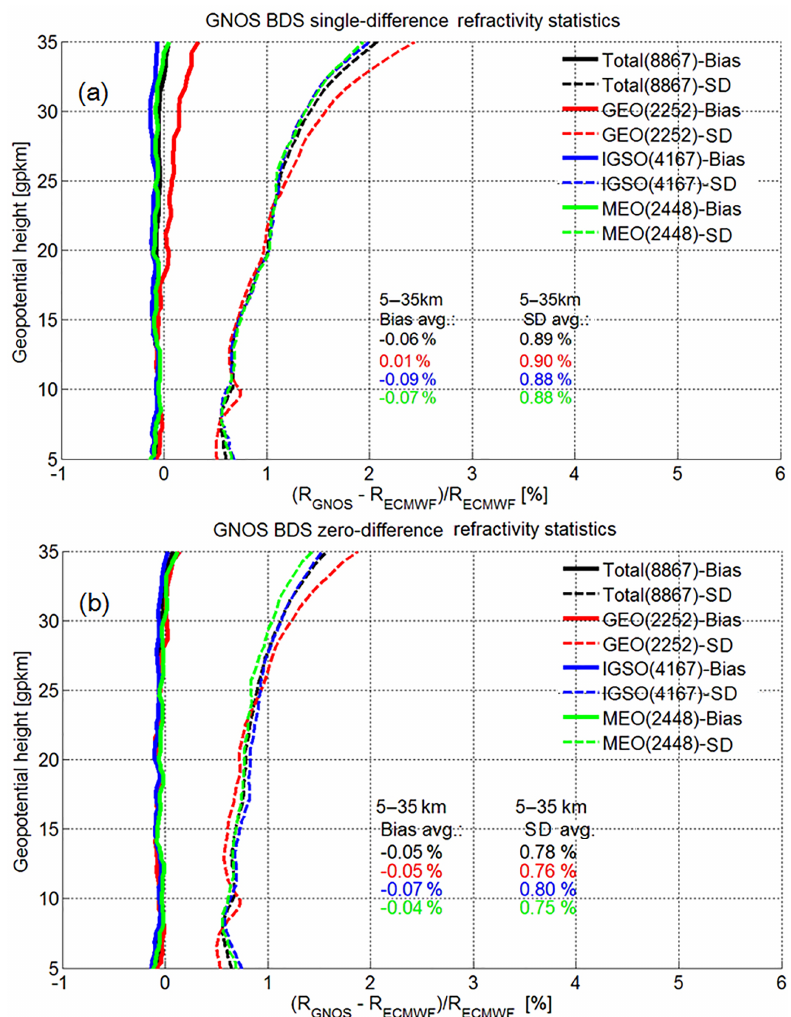
Figure 8. Mean difference (bias) and standard deviation (SD) statistics of the GNOS refractivity profiles retrieved by using excess phases from the single-difference processing (a) and the zero-difference processing (b) , respectively, with the co-located ECMWF refractivity profiles used as reference. Same layout as Fig. 6; see caption there for further